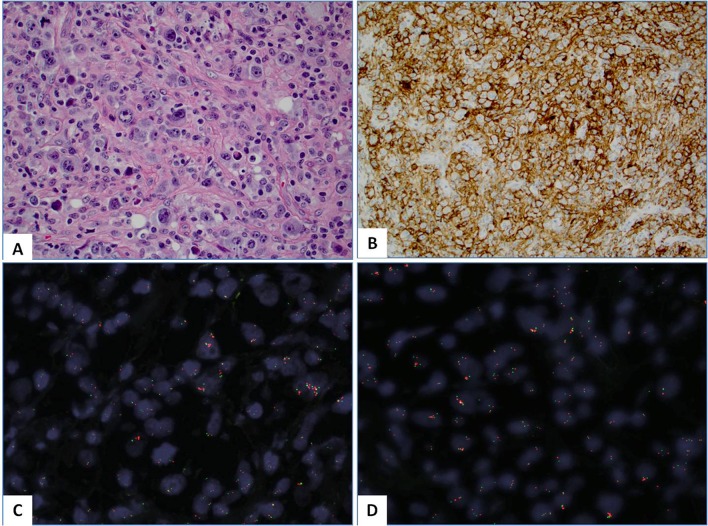
(A): Hematoxylin and Eosin (H&E) slide of a case of lymphocyte depleted variant of classical Hodgkin lymphoma (cHL); (B): The tumor cells were diffusely (100%) and strongly (3+) positive for PD-L1 protein by immunohistochemistry (clone: SP142); (C-D): FISH) assay revealed the PD-L1 and PD-L2 gene amplification (>6 PD-L1 copies per tumor cell) (C) and JAK2 gene (D). Note that red signals designate the probe that covers PD-L1/PD-L2/JAK2 genes at 9p24.1 while the green signals highlight the peri-centromeric region of the chromosome 9.